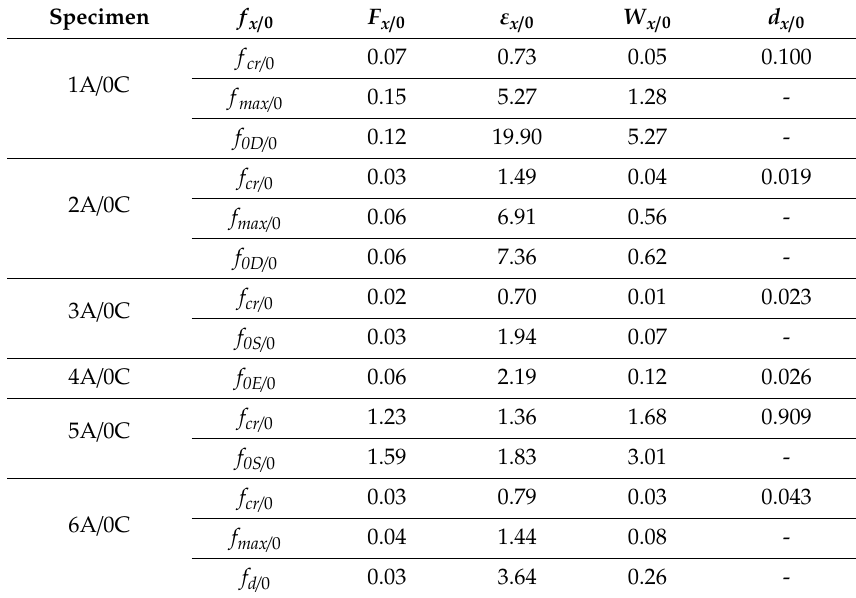
Table 4. Resins 1A, 2A, 3A, 4A, 5A and 6A compared with the reference specimen 0C . Specimen